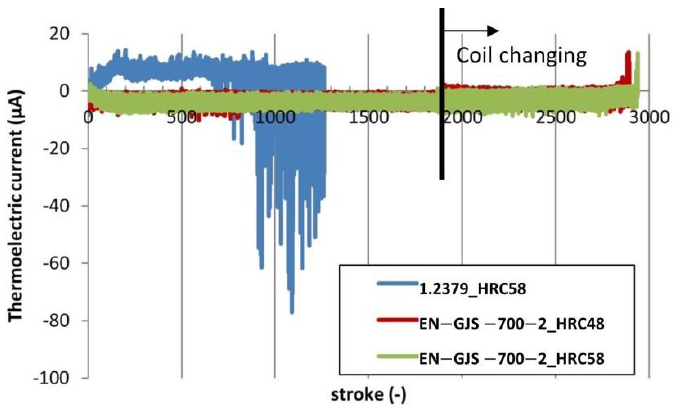
Figure 24. Evolution of thermoelectric current with the stroke number in strip drawing test.